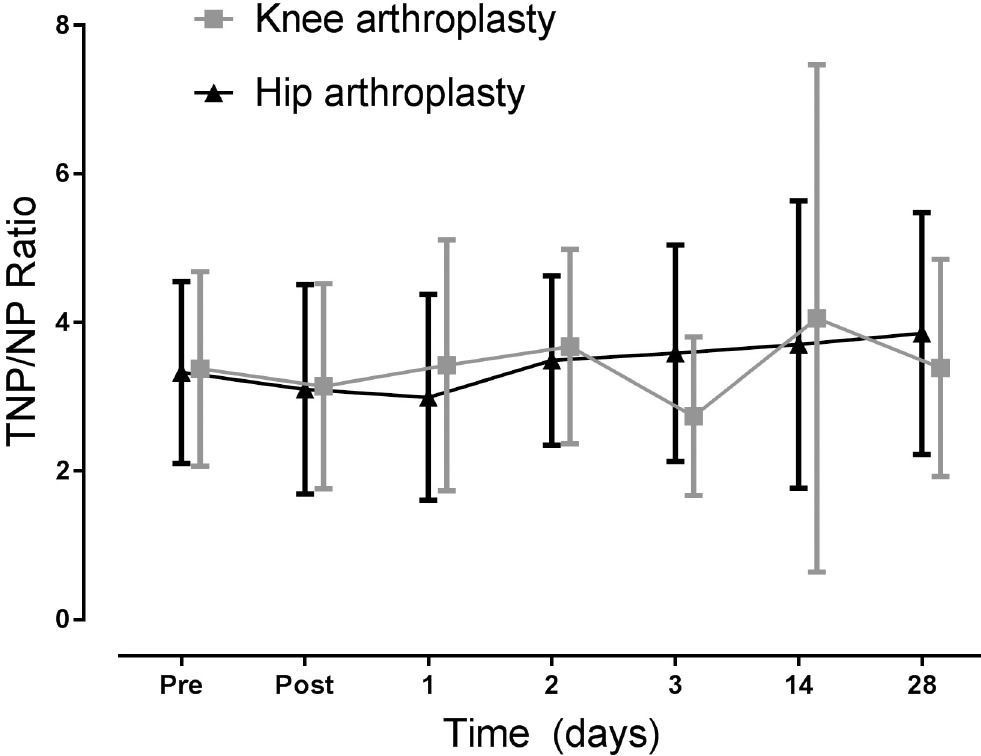
Fig 2. Total neopterin over neopterin ratios for knee and hip arthroplasty patients before and after surgery. There are no statistically significant differences in the TNP/NP ratios between the groups at any day. Data is presented as means with standard